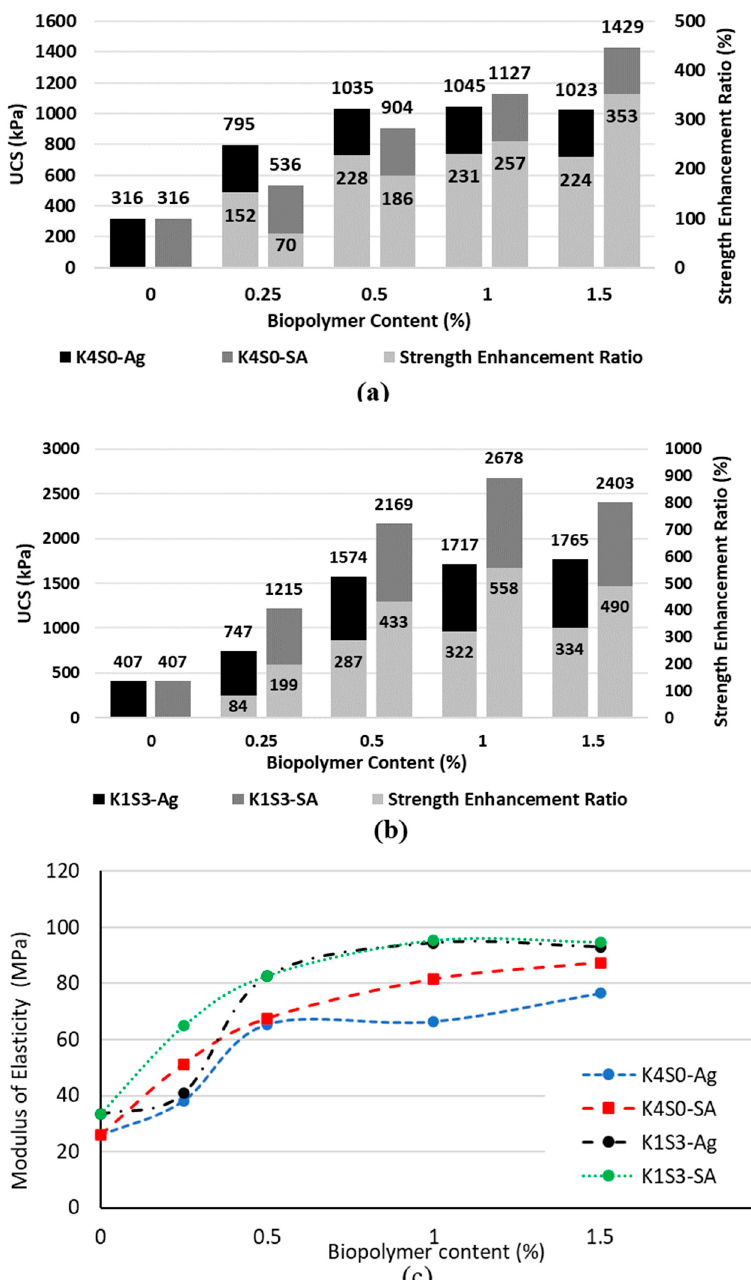
Figure 2. Biopolymer-induced Strength and enhancement ratio for treatment of ( a ) kaolinite, ( b ) K1S3, ( c ) modulus of elasticity.